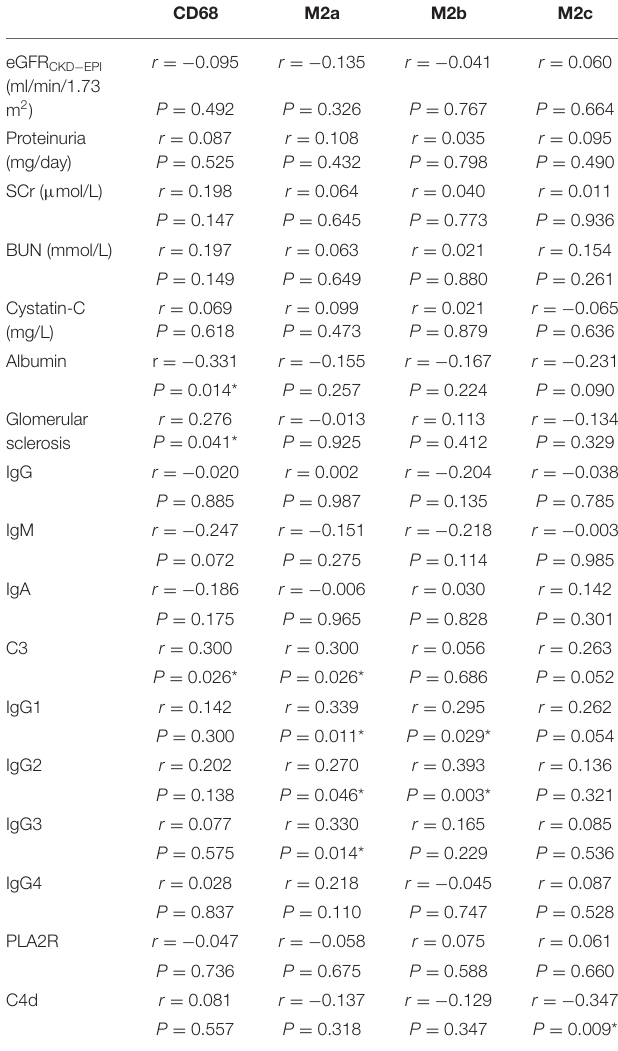
TABLE 4 | Correlation between M2 macrophage subpopulations and clinical and pathologic